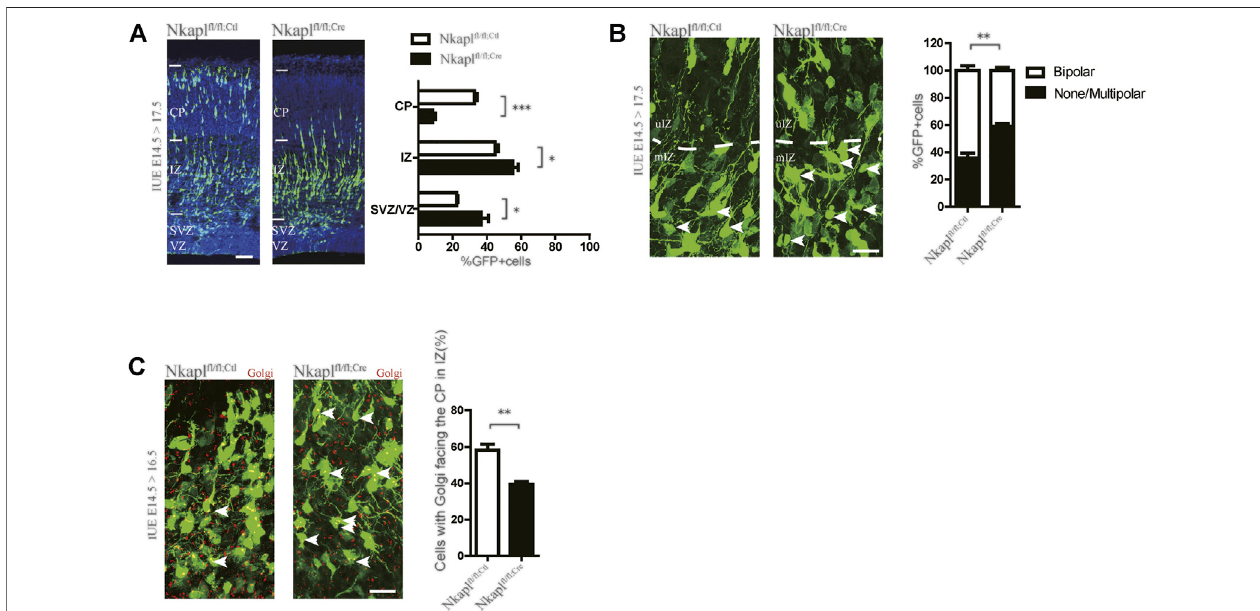
FIGURE 2 | Depletion of Nkapl impairs embryonic radial migration ofprojection neurons. (A) Left panels, Nkapl fl / fl brains were electroporated in utero at E14.5 with IRES-EGFPorCre-IRES-EGFPplasmidsandanalyzedatE17.5.NucleistainedwithHoechsttomarkdistinctCP,IZ,andSVZ/VZlayers.Scalebar,50 μ m.Rightpanels, the distribution of cortical neurons at E17.5 after electroporation ( n = 12 slices from three Nkapl fl / fl :Ctl mice and n = 12 slices from three Nkapl fl / fl :Cre mice). (B) Left panels, Nkapl fl / fl brainswereelectroporatedinuteroatE14.5withIRES-EGFPorCre-IRES-GFPplasmidsandanalyzedatE17.5.Arrow,none,ormultipolarneurons.Scale bar,20 μ m. Rightpanels,percentagesofunipolar/bipolarandmultipolarneuronsineach condition( n =12slicesfromthree Nkapl fl / fl :Ctl mice and n =12slicesfrom three Nkapl fl / fl :Cre mice). (C) Representative images and quanti fi cation of the proportion of neurons with GRASP65 facing the CP in the IZ 2 days after E14.5 electroporation in Nkapl fl / fl :Ctl and Nkapl fl / fl :Cre cells ( n = 12 slices from three Nkapl fl / fl :Ctl mice and n = 12 slices from three Nkapl fl / fl :Cre mice). Scale bar, 20 μ m. Data were expressed as mean ± SEM, 2-tailed student ’ s t-test, * p < 0.05; ** p < 0.01; *** p <